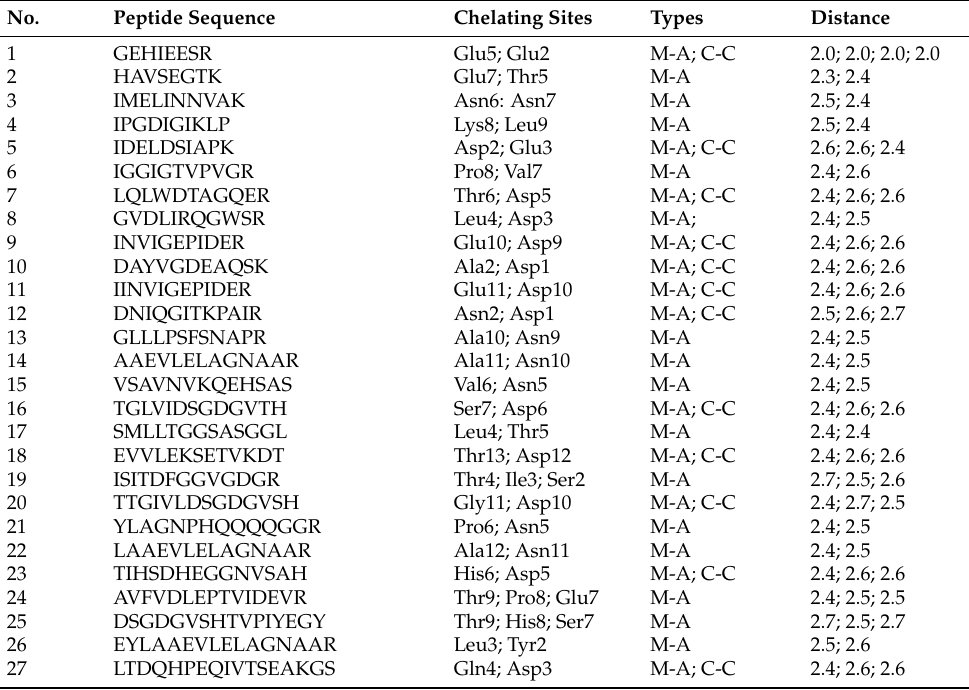
Table 3. Docking profiles of the WP and ferrous